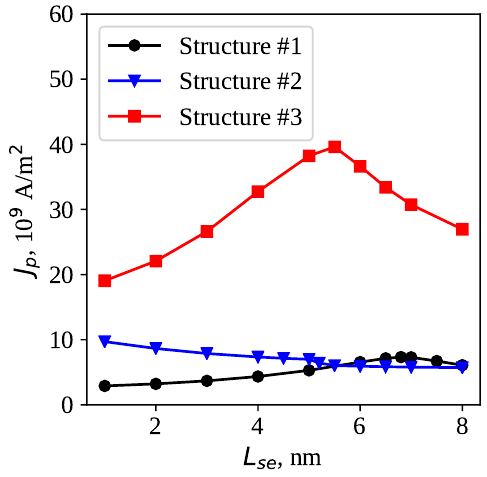
Figure 6. The dependence of the peak current on the thickness of the emitter spacer calculated in the simplified model (without the accumulation charge effect and highly doped contact layers) for the considered resonant tunneling